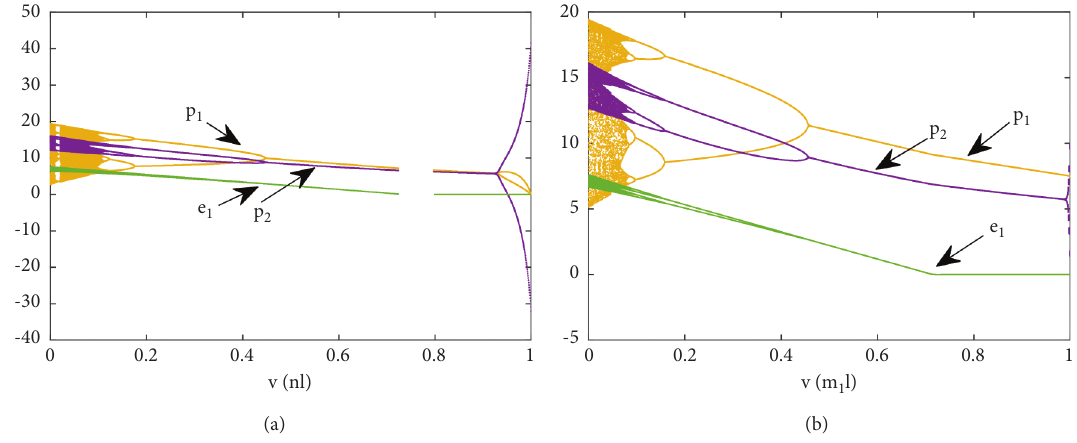
Figure 16: Bifurcation diagram with v